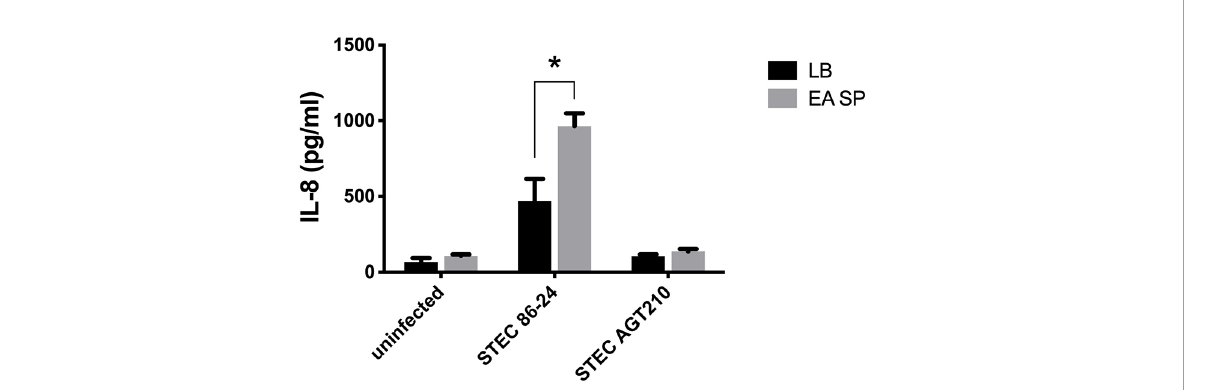
FIGURE 7 Induction of IL-8 secretion by STEC 86-24 and STEC AGT210 in the presence of EA SP. T84 cells were infected with STEC wild-type strain or STEC double mutant in Lpf fi mbriae (AGT210) in the presence of the supernatant obtained from the overnight growth of E. albertii (EA SP). As a negative control, we used uninfected cells incubated with EA SP or with LB, the medium used to prepare the supernatant. Three hours post-infection, the level of IL-8 secretion was evaluated by ELISA. Graphed data are the mean of one representative experiment performed in triplicate, with the error bars indicating standard deviation. * p < 0.05 by ANOVA and multiple comparison analysis.